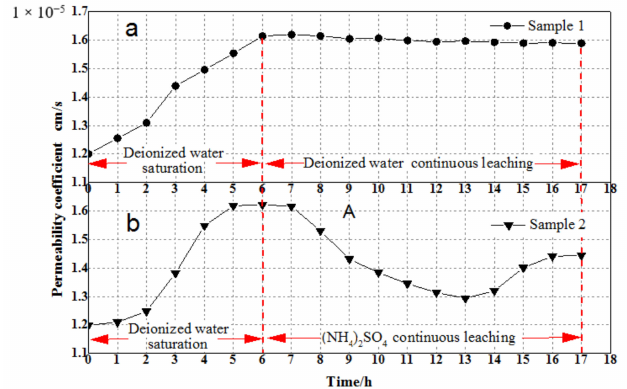
Figure 2. Permeability coe ffi cient profiles of samples in di ff erent leaching liquids. ( a ) Sample 1 was leached with deionized (DI) water; ( b ) sample 2 was leached with a (NH 4 ) 2 SO 4 solution.